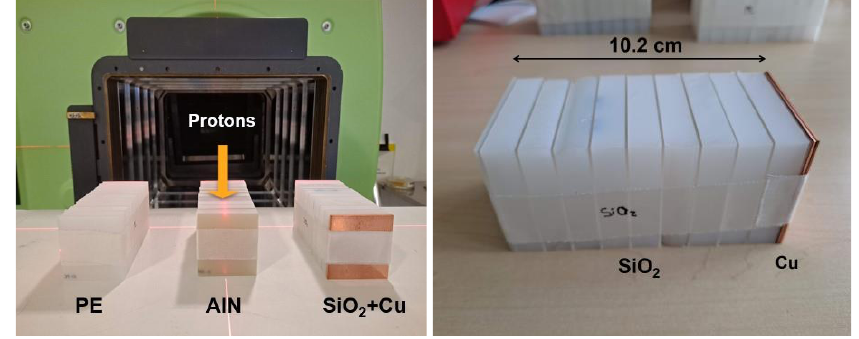
Figure 1 . Left: Experimental setup during the irradiations. Right: The SiO 2 stack made of 10 thin foils of SiO 2 between thicker PE degraders. The first and last foils are the PE monitor foil and copper, respectively.